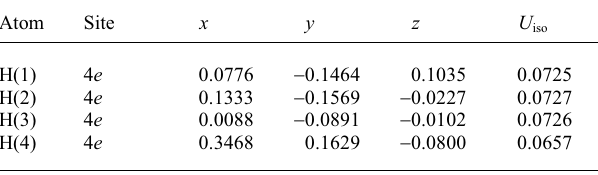
Table 3. Atomic coordinates and displacement parameters (in Å 2 )